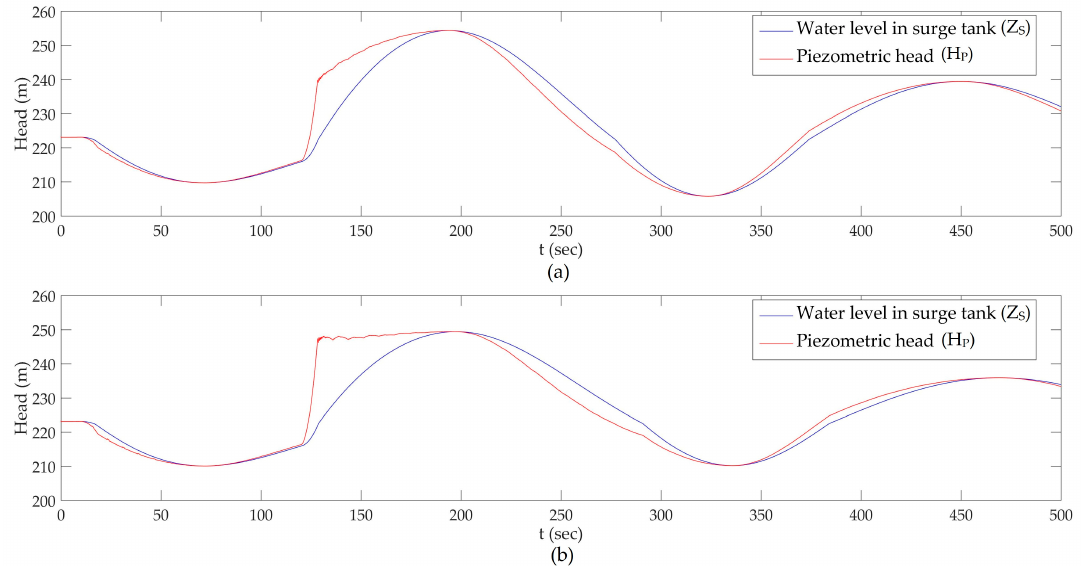
Figure 12. Piezometric head at the bottom tunnel of the surge tank and the water level in the surge tank before optimization ( a ) and after optimization ( b )